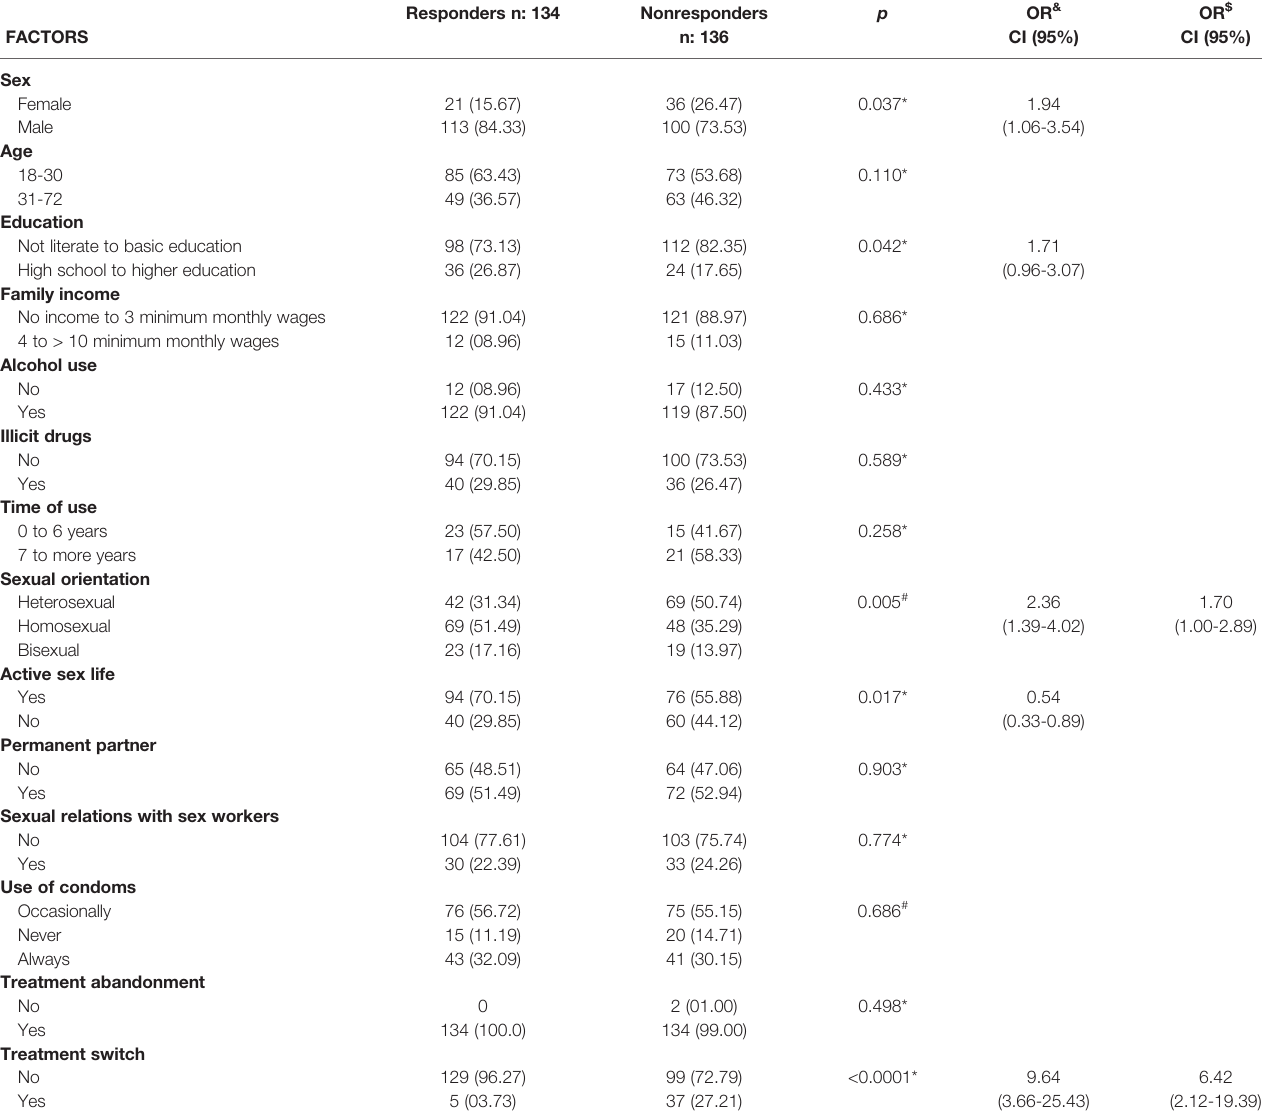
TABLE 2 | Epidemiological, sociodemographic and therapeutic factors associated with nonresponse to ART in